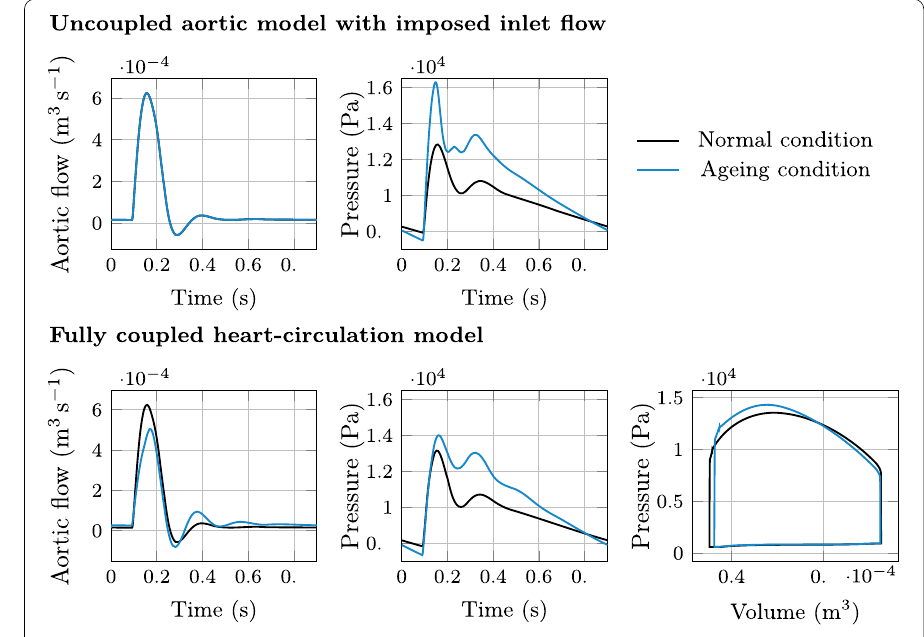
Fig. 11 The important role of the cardiac model as an inlet condition for the distributed arterial model is highlighted comparing the output of the uncoupledaorticmodel (top left and right) and the fullycoupled model (bottom left to right) settings, with a focus on the effects of ageing on the elastic arteries. On the left we depict the blood flow at the first element of the aortic model, in the center we show the aortic pressure ( P ar ) at the same space element and at the bottom right we depict the pressure-volume loops in the left ventricle, for normal physiological conditions (black line) and for an arterial ageing conditions (blue